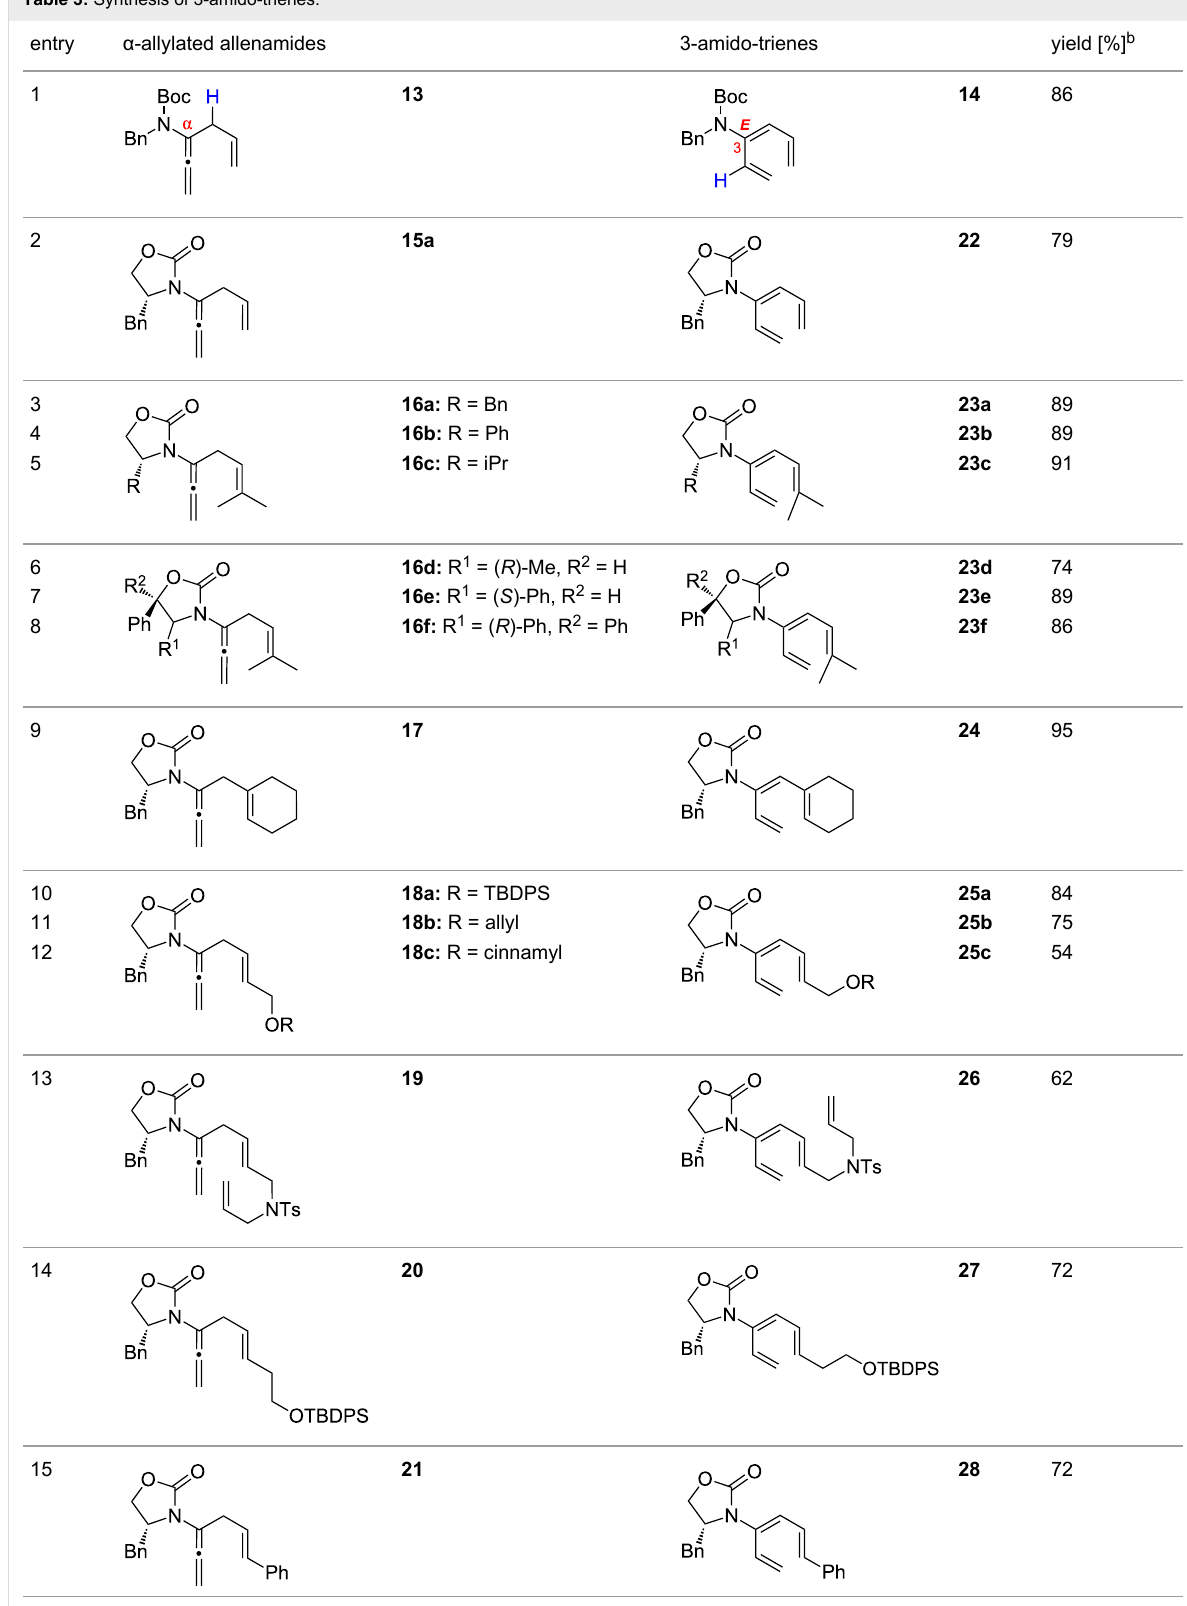
Table 3: Synthesis of 3-amido-trienes. a